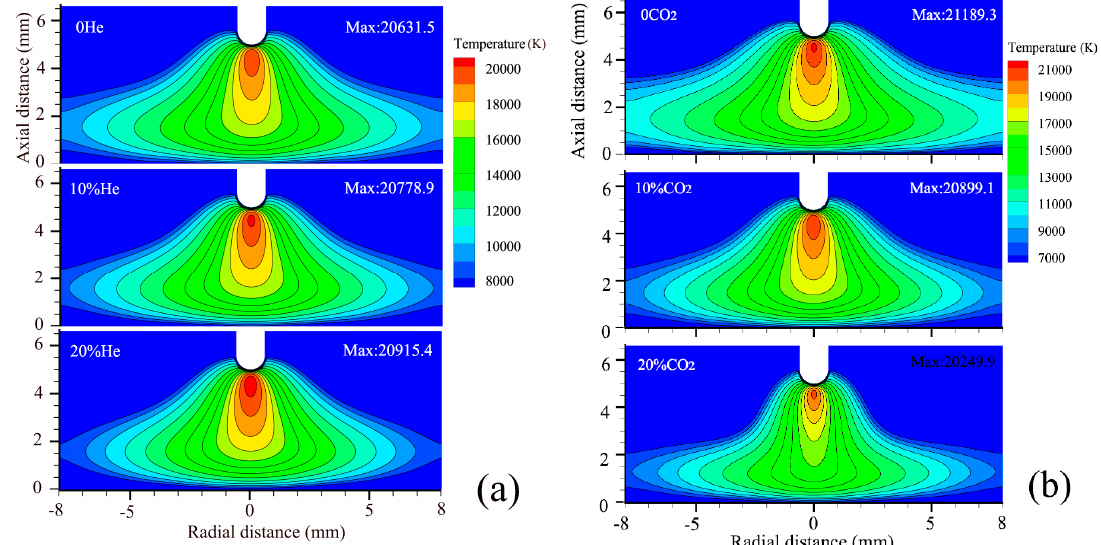
Figure 6. Arc temperature distribution under different helium ( a ) or CO 2 contents ( b ) for bead-on-plate geometry; the CO 2 content is 10% in ( a ) and the He content is 5% in ( b ).